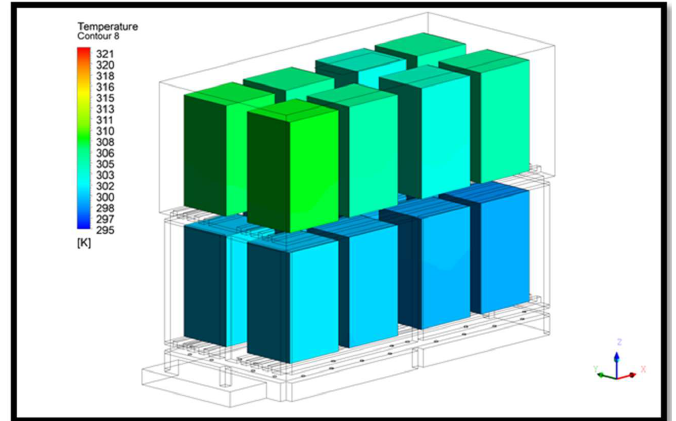
Figure 18. Air flow profile for the vented cooling design. An improved distribution of air can be seen in comparison to the profile shown in Figure 15.